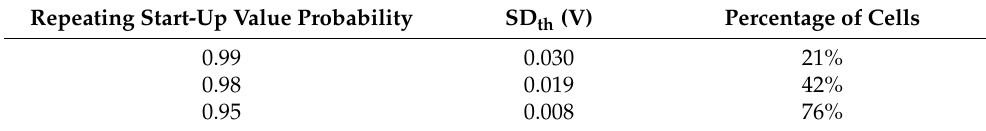
Table 3. SD th parameter value and percentage of cells for different repeating start-up value probabilities. Repeating Start-Up Value